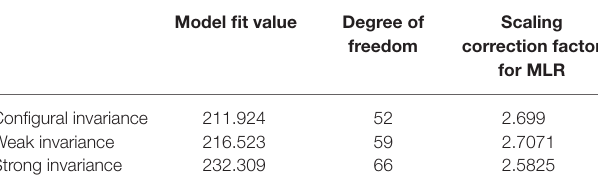
TABLE 3 | Fit statistics of configural, weak and strong invariance models in Study